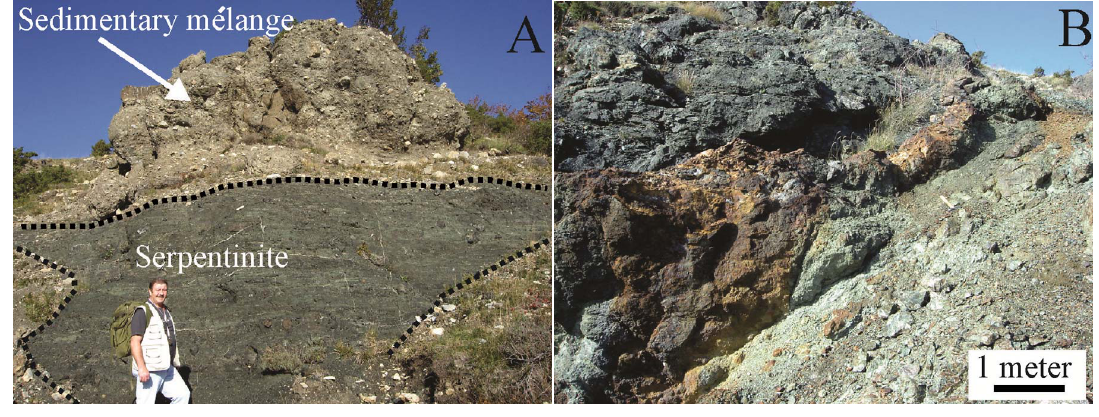
Figure 3. ( A ) Field view of the contact serpentinite-sedimentary mélange of an unmineralized serpentinite, cropping out 300 m from the Pozzo mine and ( B ) external view of the Pozzo deposit, showing the contact between serpentinite and massive sulfide body.